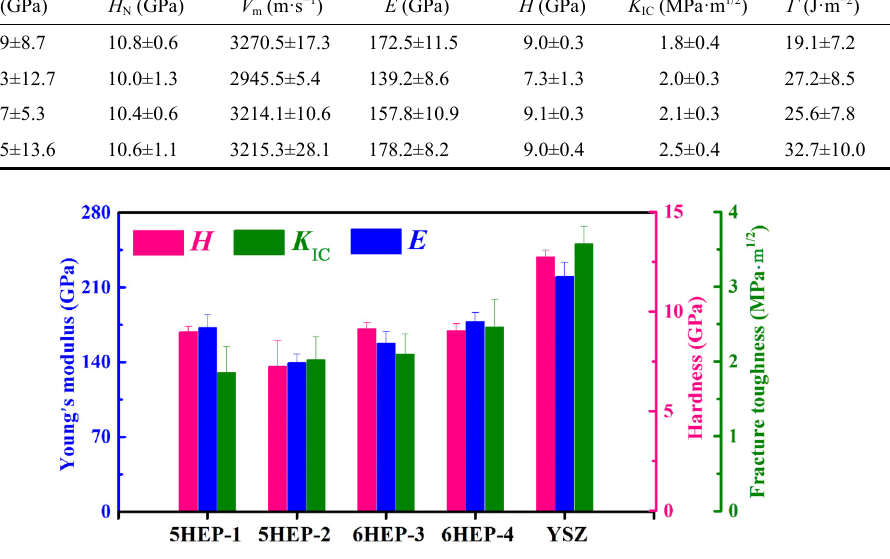
Fig. 3 Comparison of Young’s modulus, hardness, and fracture toughness of (La 1/5 Pr 1/5 Dy 1/5 Ho 1/5 Tm 1/5 )Ta 3 O 9 (5HEP-1), (Gd 1/5 Dy 1/5 Ho 1/5 Er 1/5 Tm 1/5 )Ta 3 O 9 (5HEP-2), (La 1/6 Sm 1/6 Eu 1/6 Dy 1/6 Ho 1/6 Tm 1/6 )Ta 3 O 9 (6HEP-3), (Eu 1/6 Gd 1/6 Dy 1/6 Ho 1/6 Er 1/6 Tm 1/6 )Ta 3 O 9 (6HEP-4) ceramics, and YSZ.